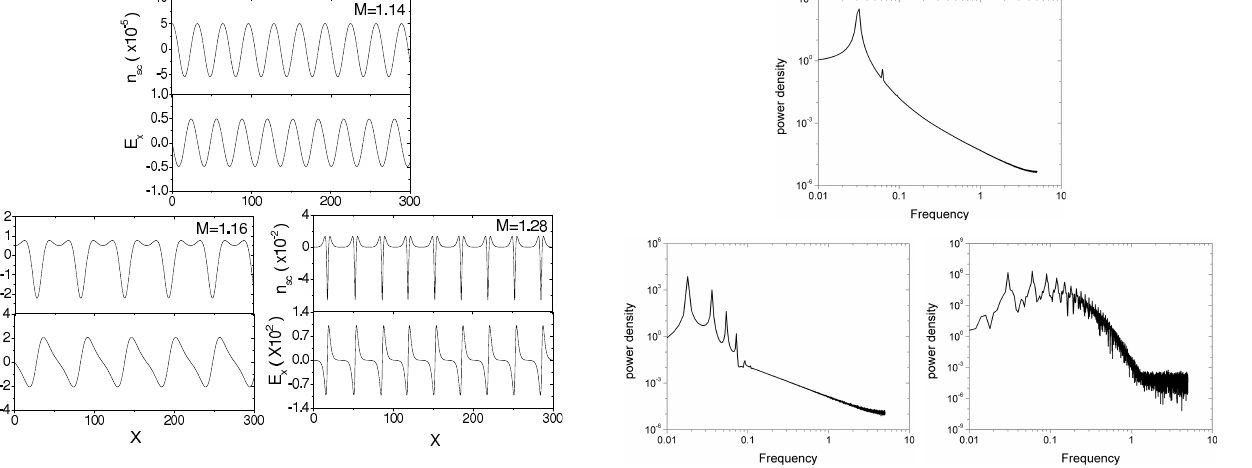
Fig. 3. FFT spectra of E x in corresponding panels of Fig.